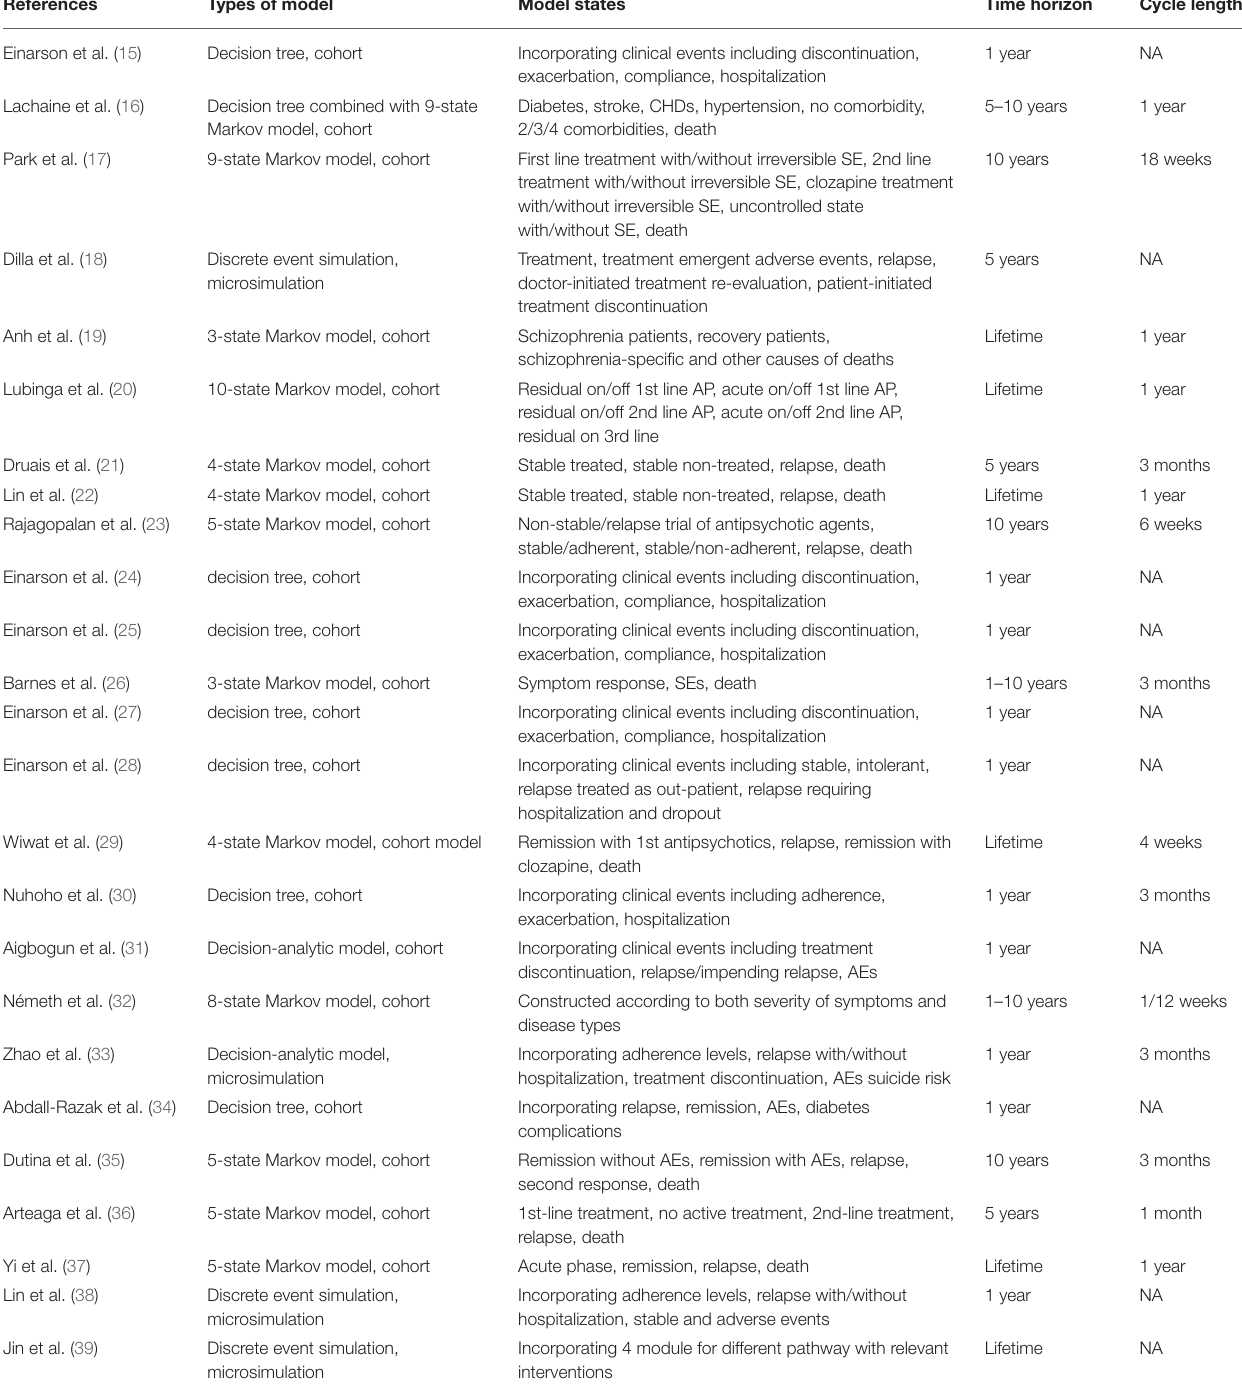
TABLE 3 | Basic characteristics of the models in the included economic